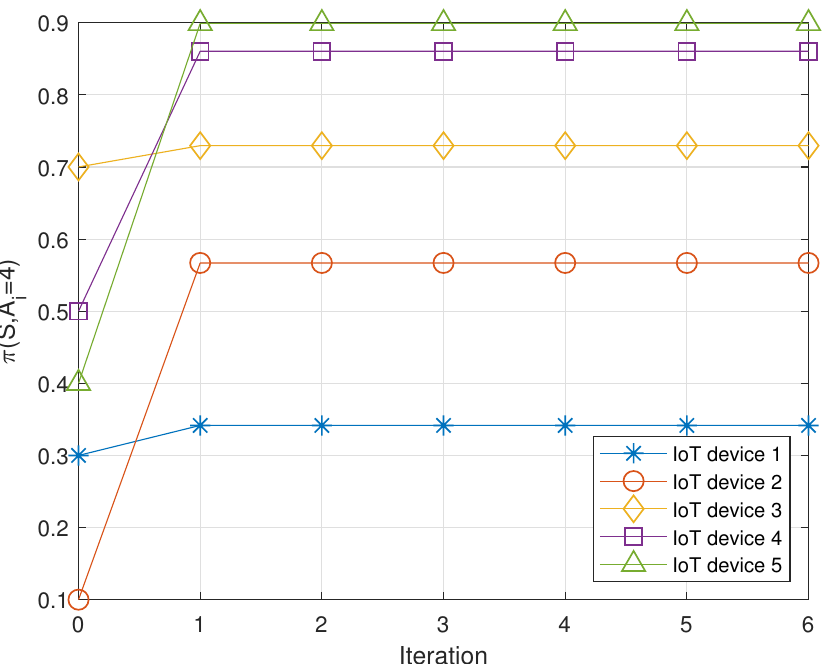
Figure 2. Process that the policies of IoT devices converge to the integrated optimal policy (i.e., Nash